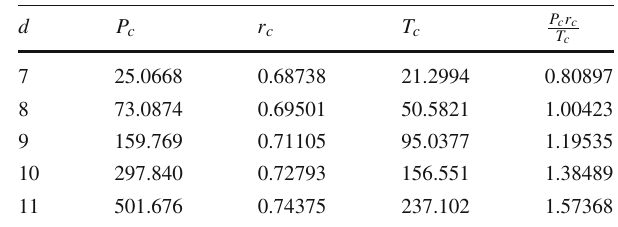
Table 2 Spherical black holes: k = 1, q = 1, m = 1, c 0 = c 1 = c 2 =